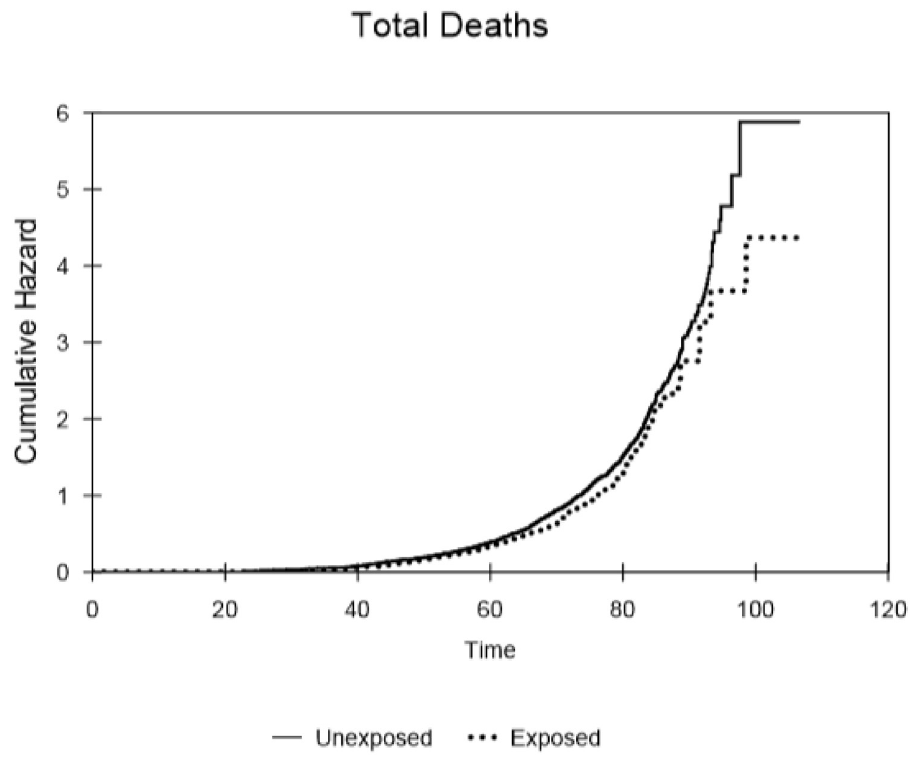
Fig 5. Cumulative hazard for all causes of death, within the selected populations of males that either received or did not receive typical 224 Ra treatment, as a function of attained age.